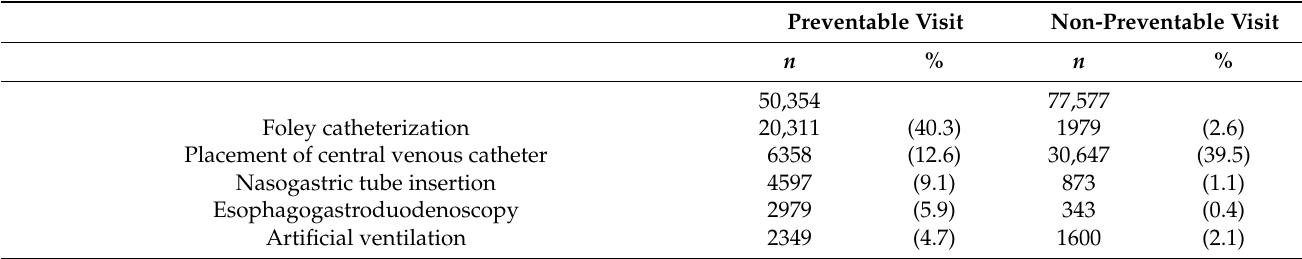
Table 6. Procedures performed in the emergency departments of patients who were transferred from